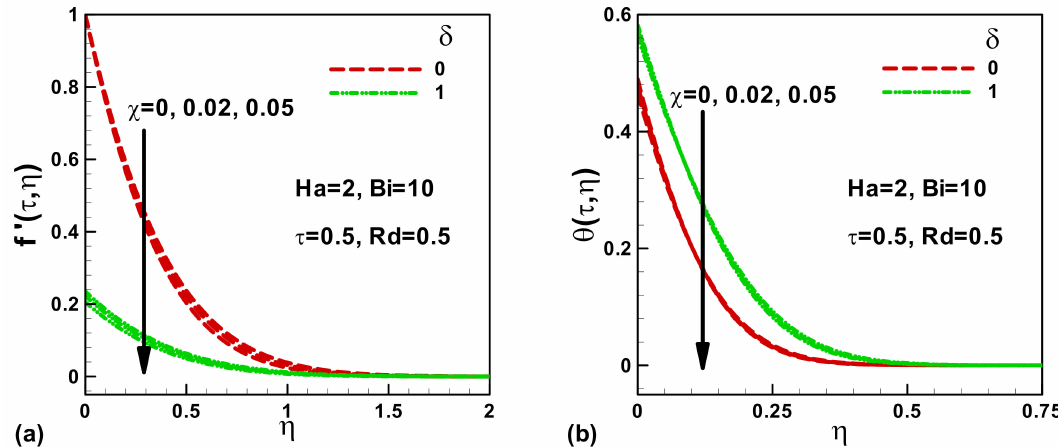
Figure 2. E ff ects of solid volume fraction of nanoparticles χ and Navier slip δ on ( a ) dimensionless velocity and ( b ) dimensionless temperature.